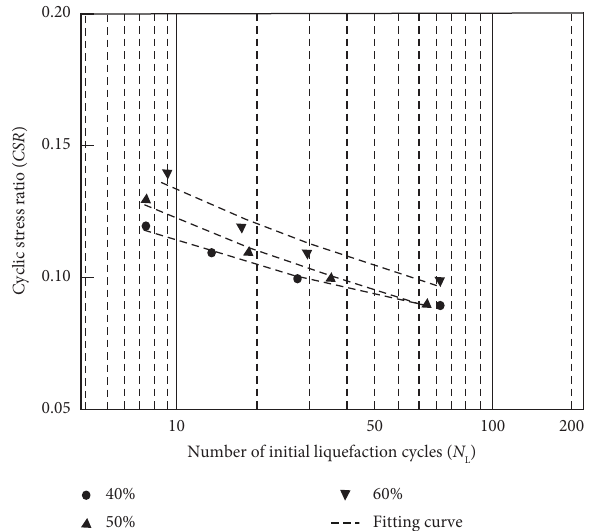
Figure 8: Correlations between the CSR and N